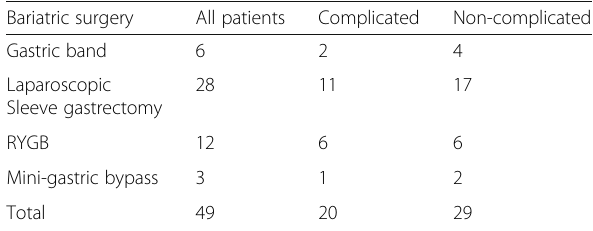
Table 1 Type of bariatric surgeries in 49 studied patients Bariatric surgery All patients